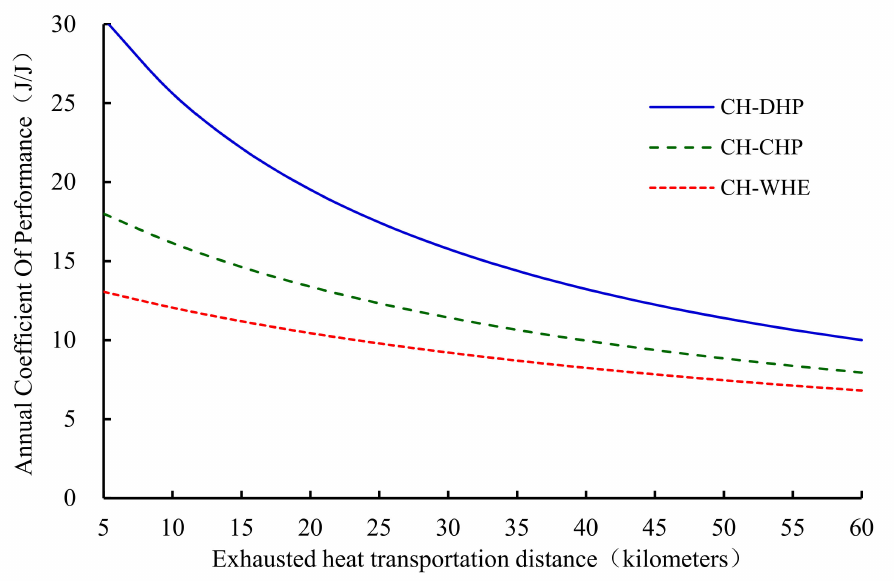
Figure 5. Impact of exhausted heat transportation distance on annual coefficients of performance ( ACOP